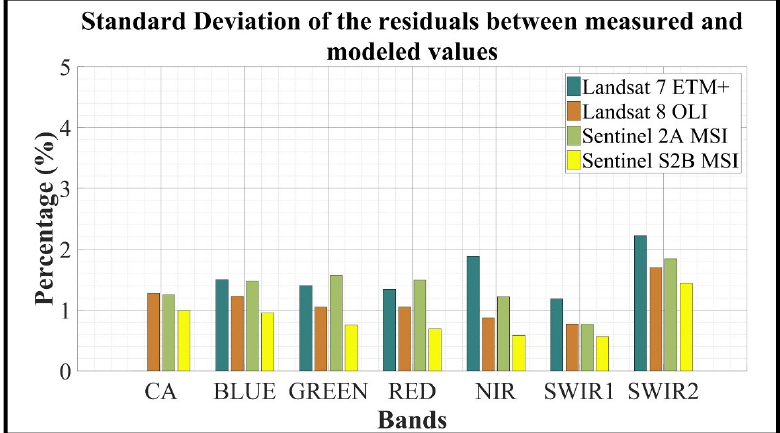
Figure 17. Estimate of accuracy between sensor observation and Egypt1 model prediction. Remote Sens. 2019 , 11 , x FOR PEER REVIEW 16 of 21